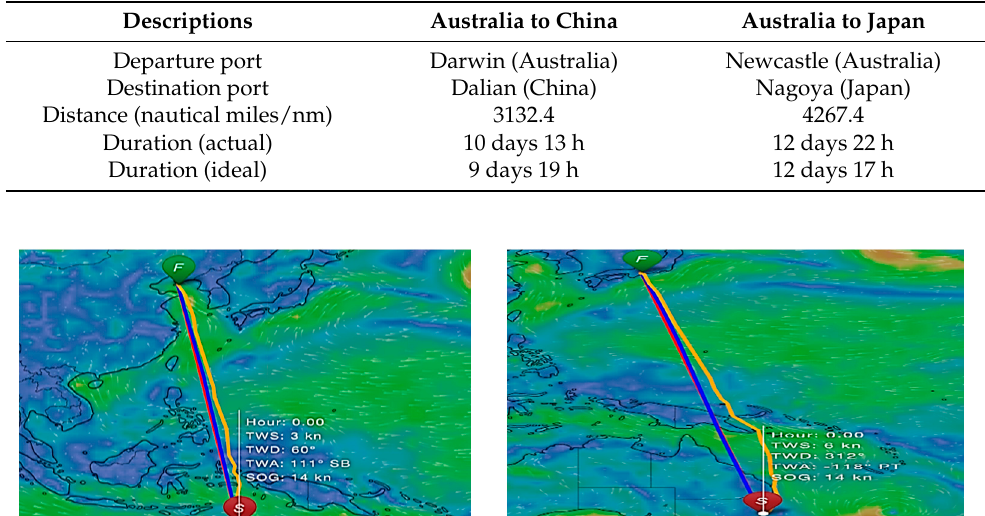
Table 2. Routes from Australia to China and Japan.